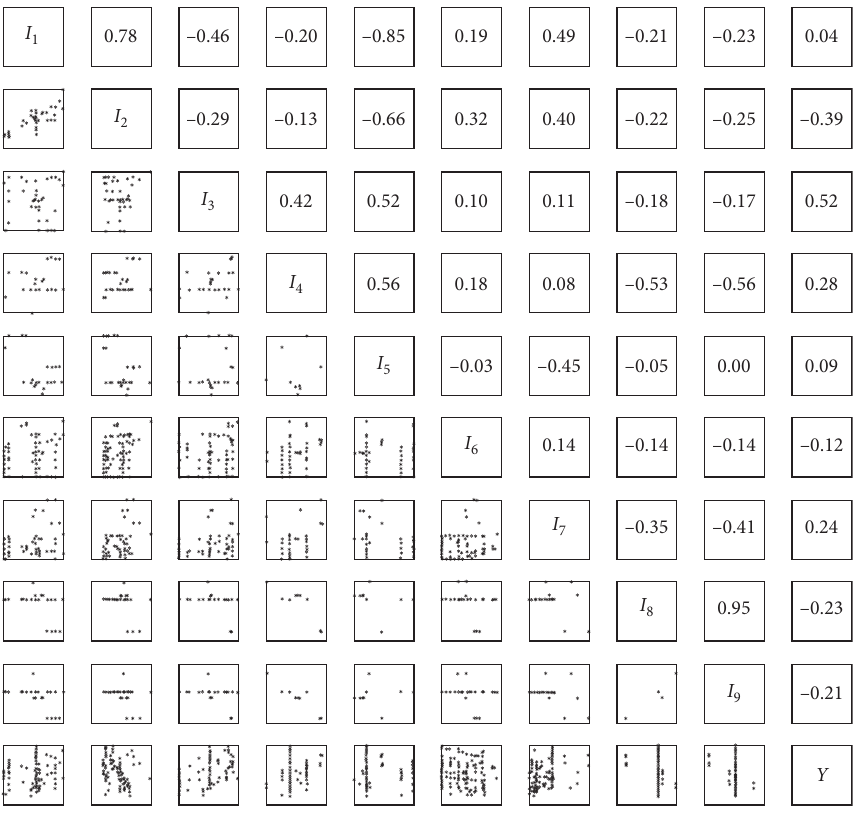
Figure 2: Correlation graphs between input and output variables used in this